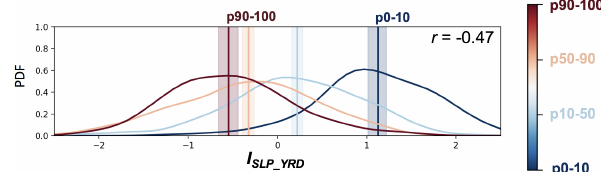
Figure 7. Frequency distributions of a circulation-based index for YRD (Eq. 1) for different percentile thresholds of daily mean PM 2 . 5 concentrations over YRD derived from nudged UKESM1 simula- tions during DJF 1999–2018. The vertical lines and shading repre- sent the averages and the associated 95% confidence intervals, re- spectively. Averages are calculated using Tukey’s trimean (e.g. Ge et al., 2019). The confidence intervals for these averages are esti- mated by using bootstrap resampling (e.g. Wang, 2001).